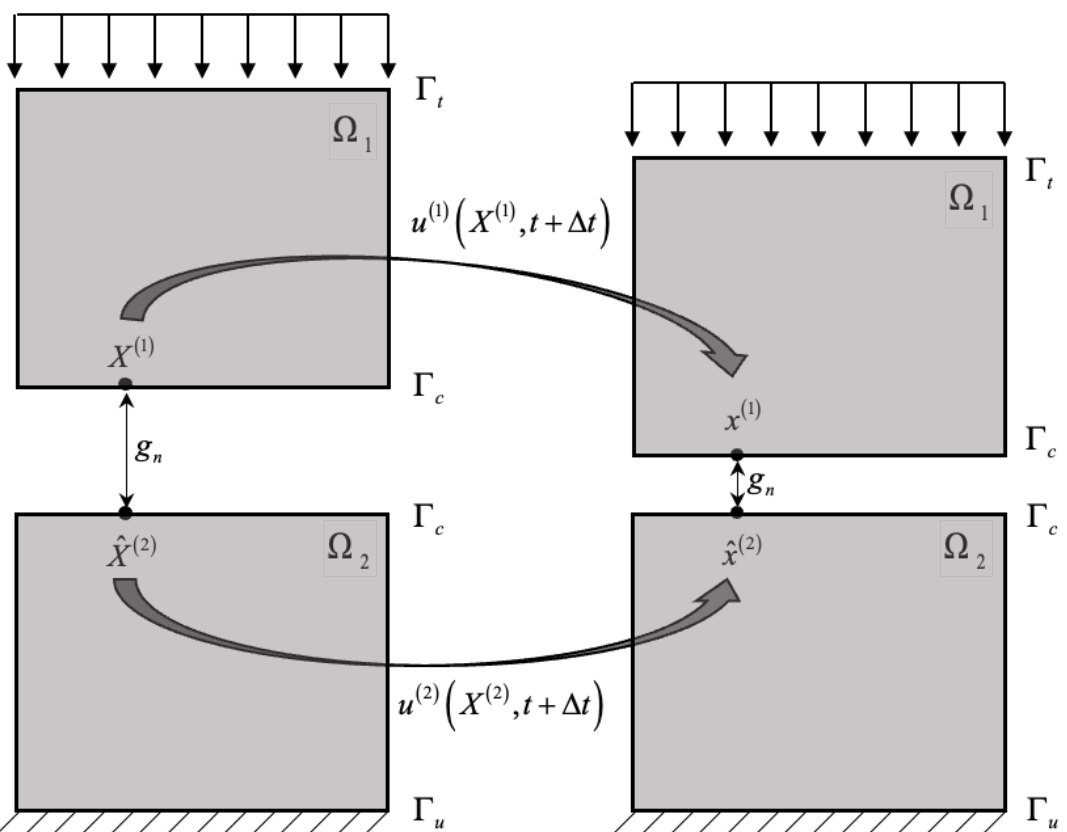
Figure 2. Schematic description for contact problem.